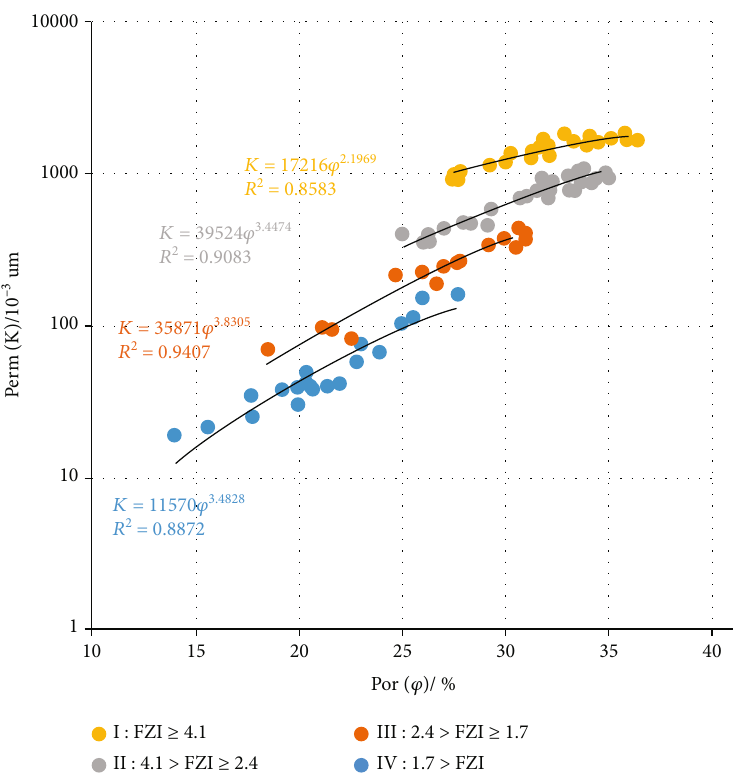
Figure 3: Relationship between porosity and permeability of di ff erent types of fl ow units.